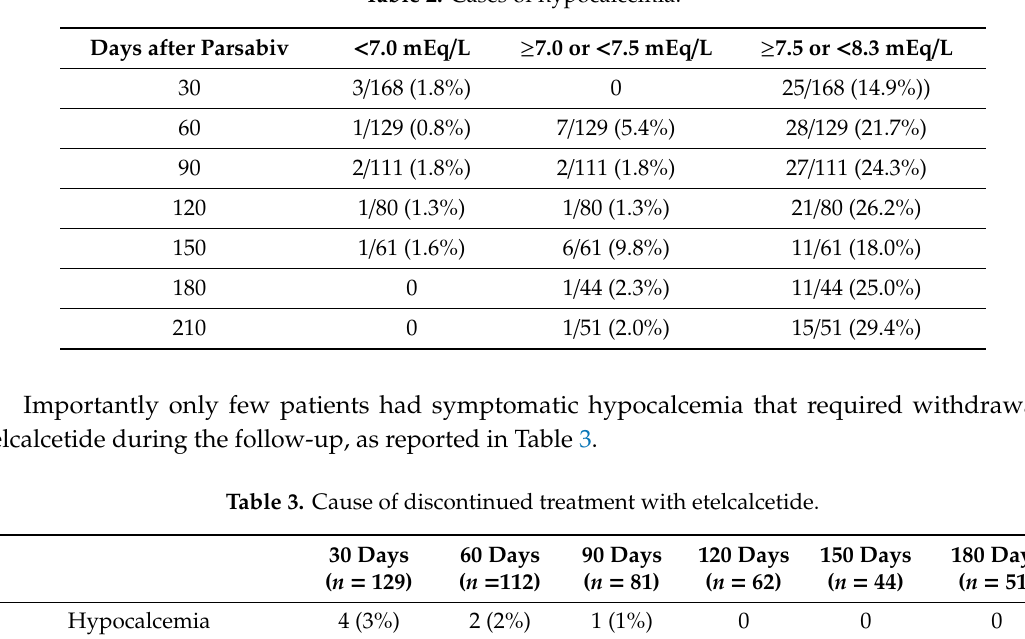
Table 2. Cases of hypocalcemia.